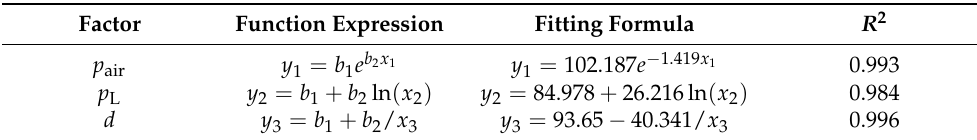
Table 5. Fitting formula between single factor and